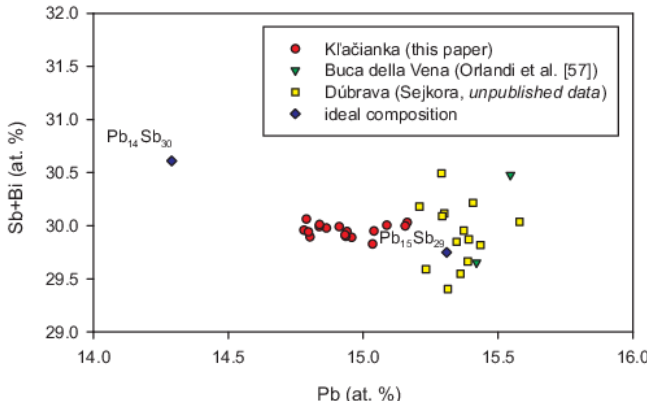
Figure 3. Chemical composition of scainiite in the graph Pb vs. Sb + Bi (at.%). Jamesonite was found as relatively abundant metallic grey fibrous aggregates up to 0.5 cm embedded in quartz gangue. In polished sections, it forms subhedral lath-like or anhedral fine-grained aggregates up to 1 mm in size, partly intergrown with galena and overgrown by subhedral crystals of boulangerite. It was also observed as short lath-like crystals and tiny inclusions enclosed in the earlier robinsonite (Figure 4a). Jamesonite is usually replaced by younger dadsonite and rouxelite. The PXRD data of jamesonite from Kl’aˇcianka agree well with the published data of this mineral phase and also with a theoret- ical pattern calculated from the crystal structure information published by L é one et al. [60]; its refined unit-cell parameters are given in Table 1. Chemical composition of jamesonite from Kl’aˇcianka (Table S4) corresponds very well to the ideal formula FePb 4 Sb 6 S 14 [54];